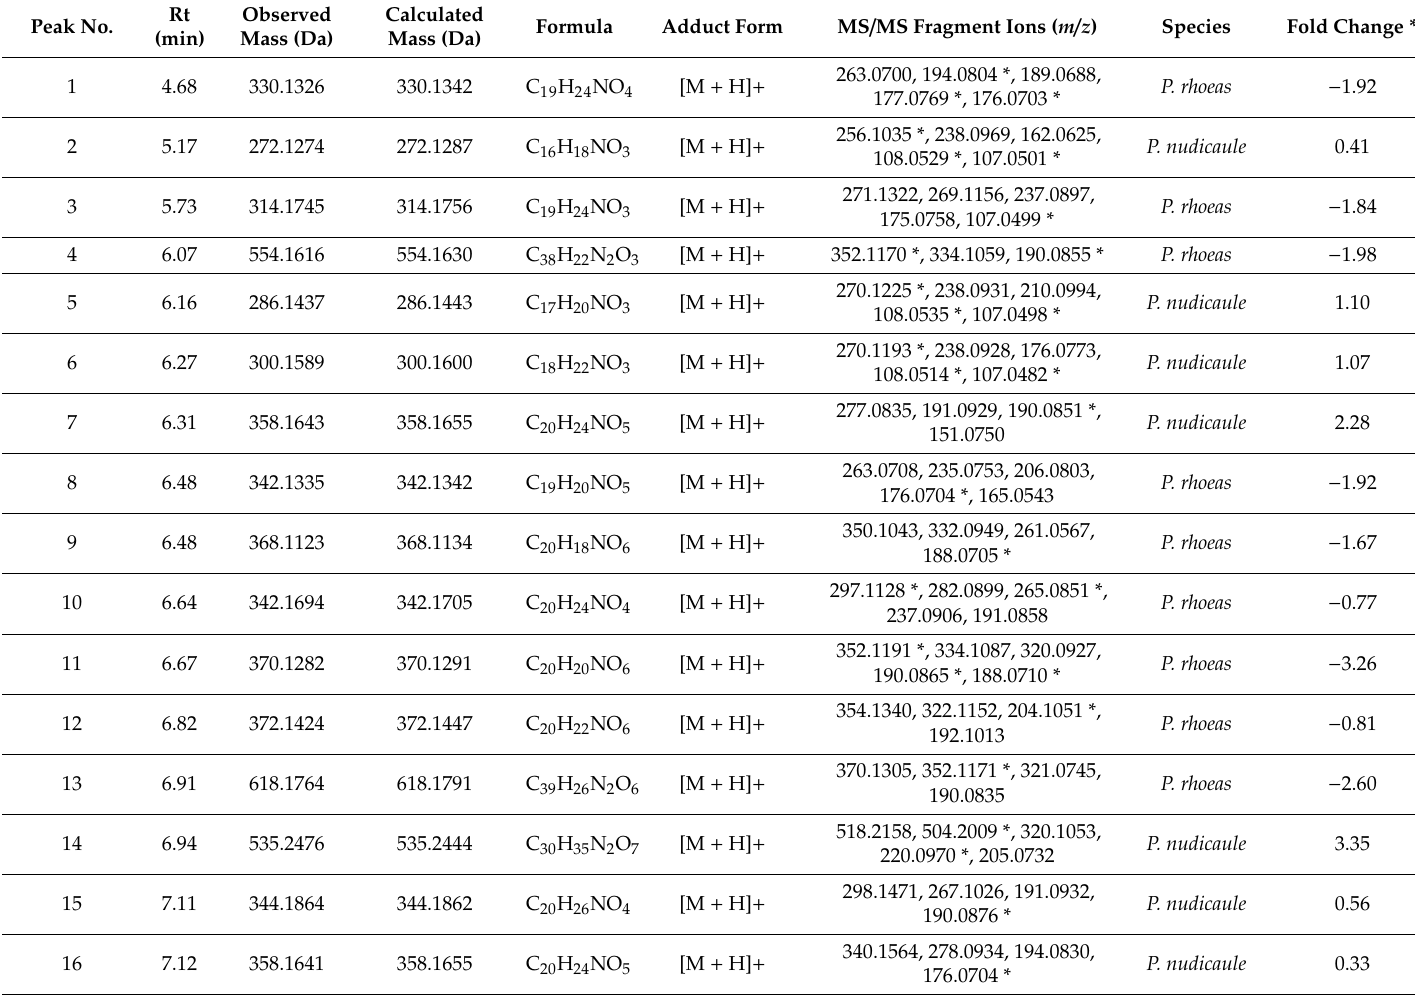
Table 1. Molecular network-based alkaloids of P. nudicaule and P. rhoeas by liquid chromatography (LC)- quadrupole time-of-flight (QTOF)-mass spectrometry (MS) /